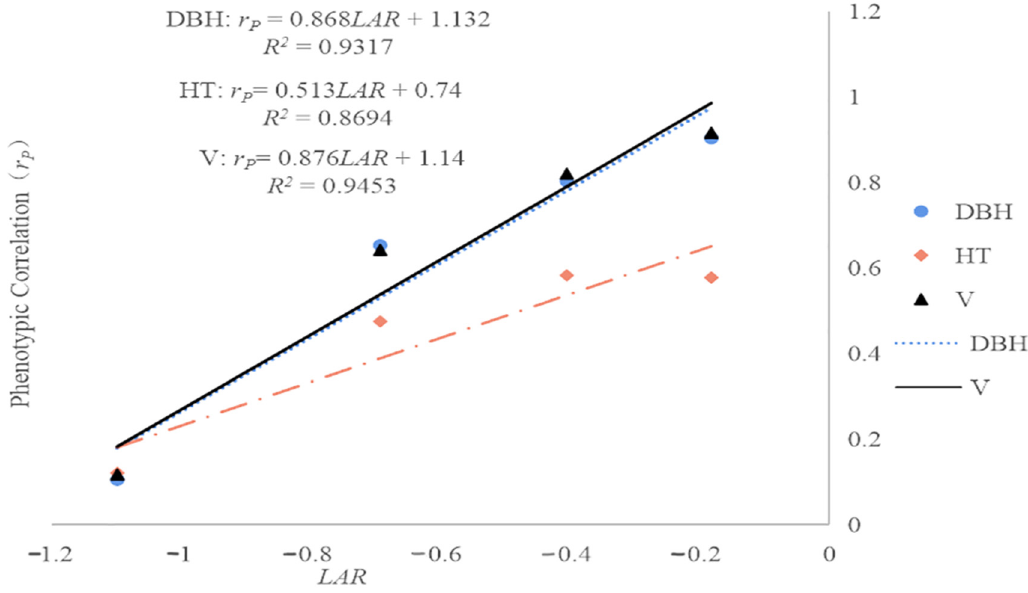
Figure 4. Relationship of LAR ( log e (age young /age old )) to age–age phenotypic correlations.